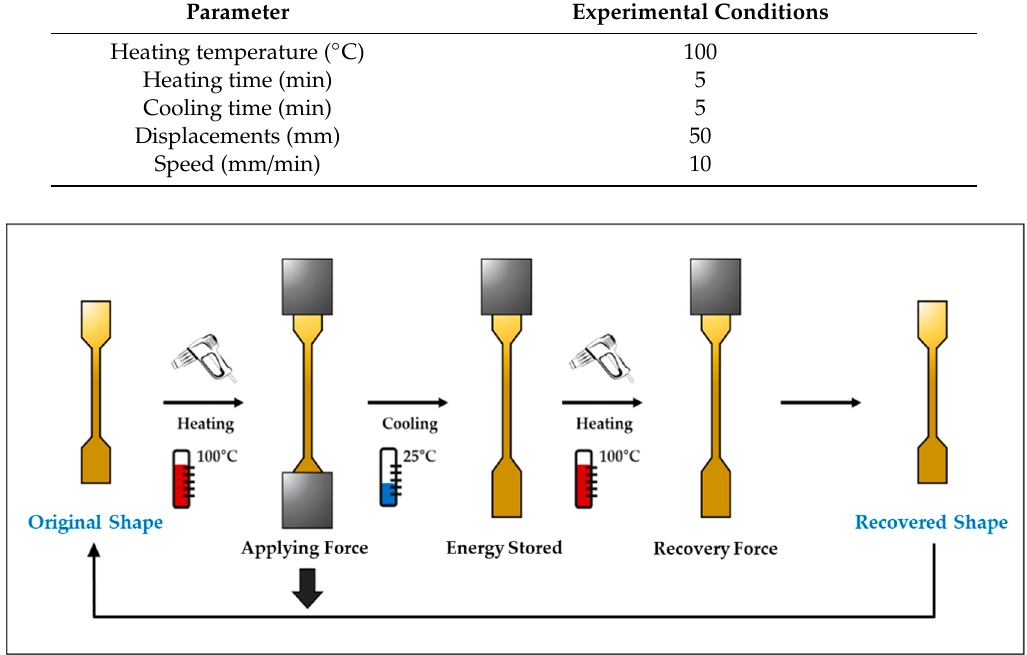
Figure 2. Experimental method employed in this study.